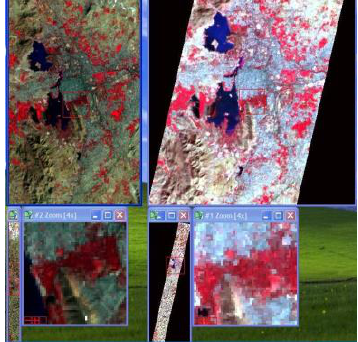
Fig 1 Original radiance and pre-processed Hyperion